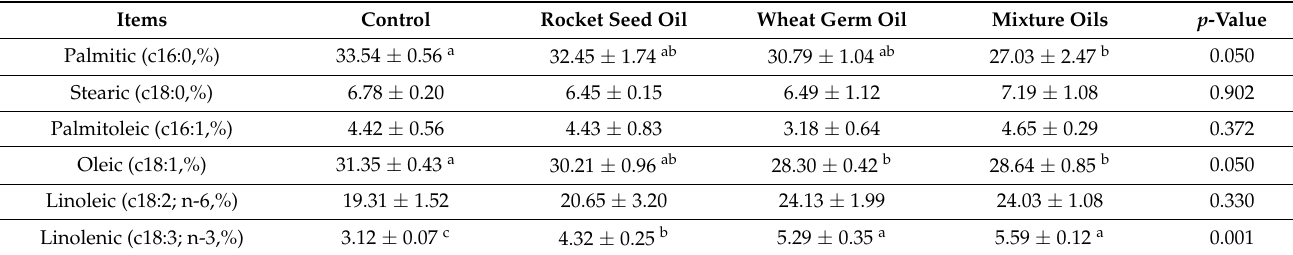
Table 4. Meat fatty acid profile of V-line growing rabbits (5–12 weeks of age) that were administered orally with rocket seed oil, wheat germ oil, and their mixture.